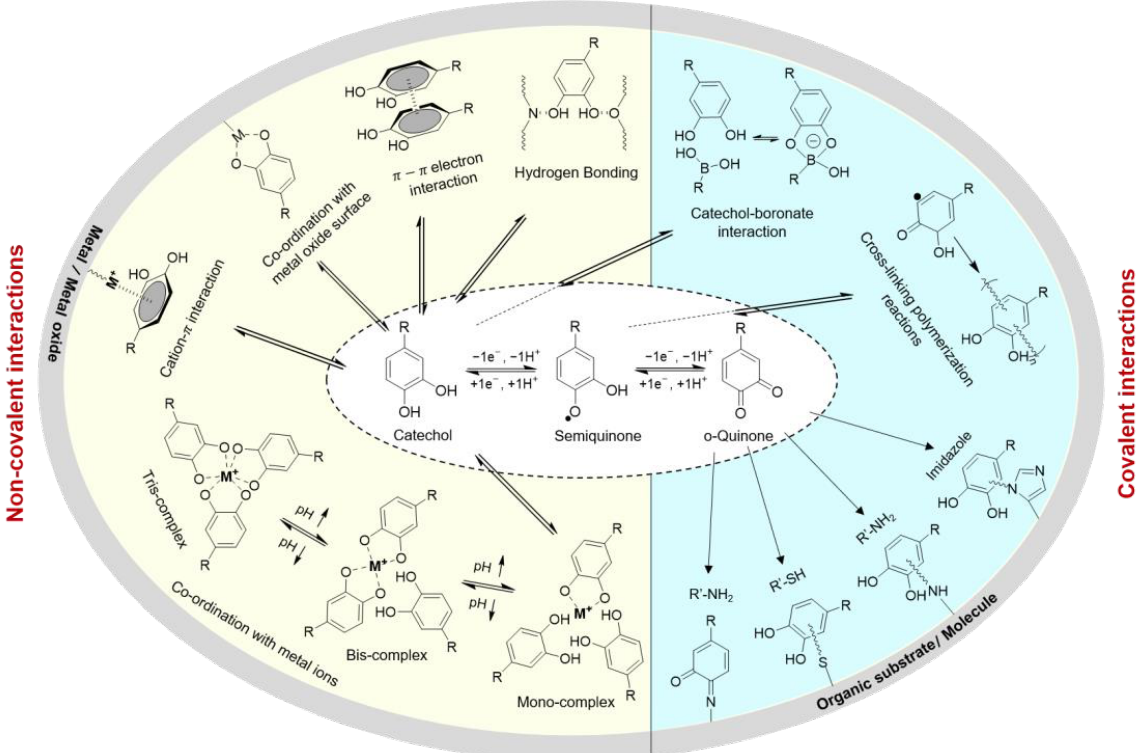
Figure 1. Possible interactions and reactions of catechol, semiquinone, and ortho-quinones. Noncovalent interactions include hydrogen bonding, π–π electron interaction, coordination with metal oxide surface, cation–π interaction, and coordination with metal ions. Covalent interactions include catechol–boronate complexation, polymerization, and irreversible bonding to organic substrates or molecules bearing, -thiol, -amine, and -imidazole functional groups.